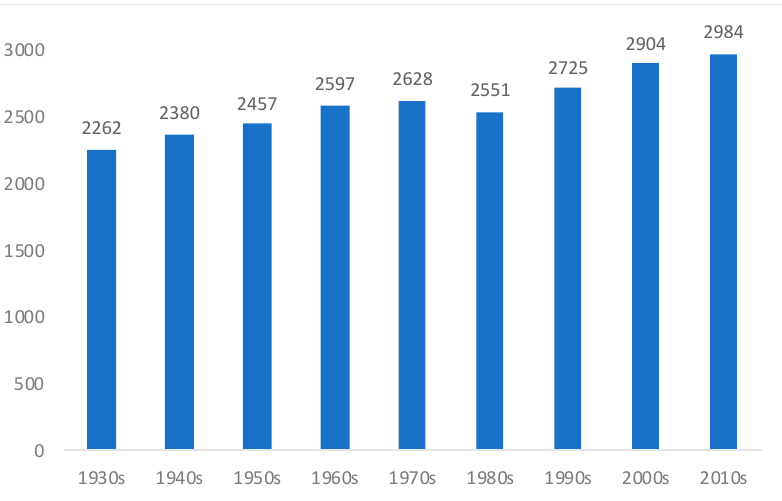
Figure 6. Chile dietary energy consumption (kcal per person per day), averages per decade, 1930s–2010s. Source: Own elaboration from Llorca-Jaña et al. [28]; and Solimano and Hakim [70]. Note: FAO online data started in 1960. Data for the previous decades were collected from printed FAO sources (detailed in Llorca-Jaña et al. [28]). Before the 1930s, and as a reference only, according to Moreno [20], the average dietary energy consumption of Chile was around 2.200 kcal per person per day, slightly below our data for the 1930s.